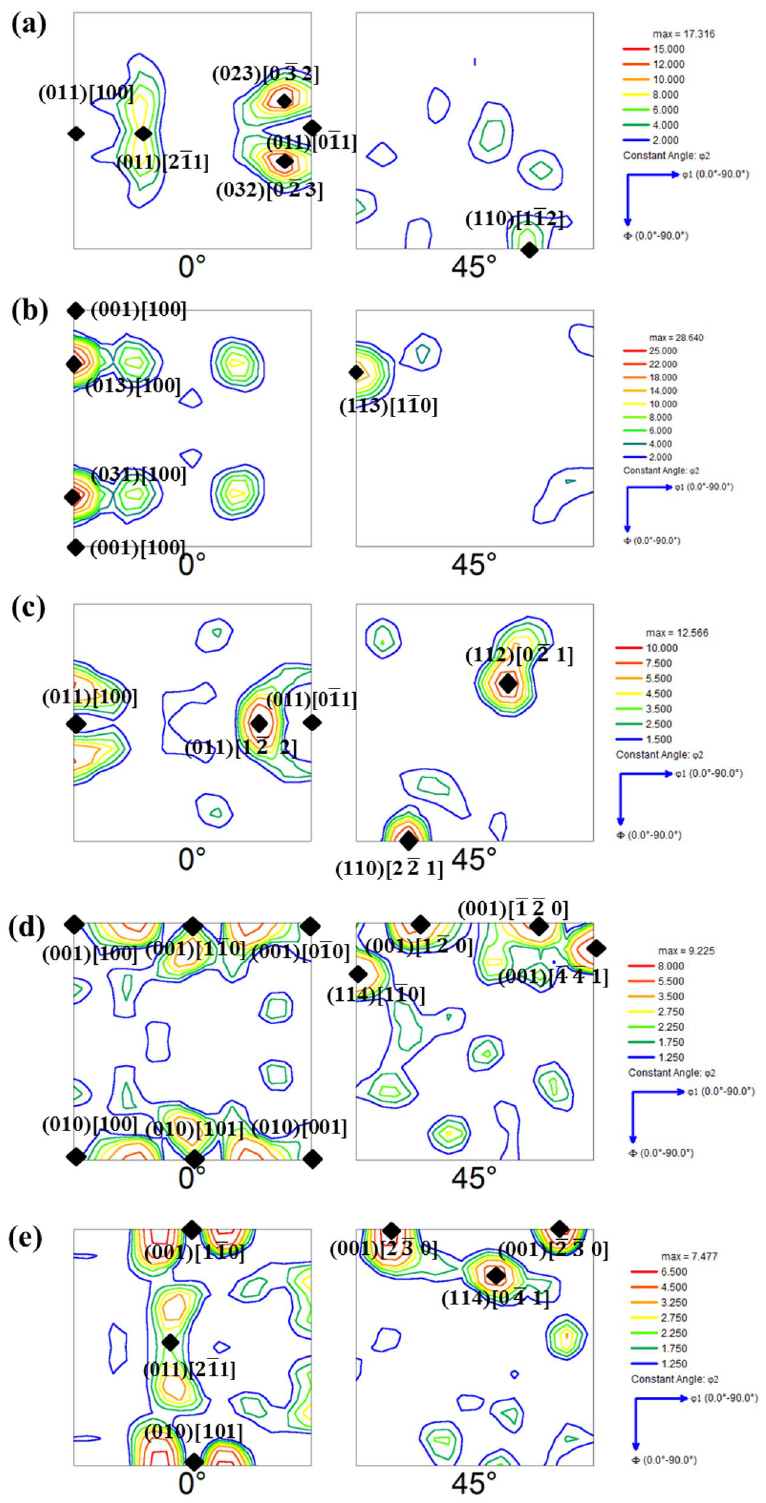
Figure 5. φ 2 = 0° and 45° sections of the ODF for ( a ) Cast 1; ( b ) Cast 2; ( c ) Cast 3; ( d ) Cast 4 and ( e ) Cast